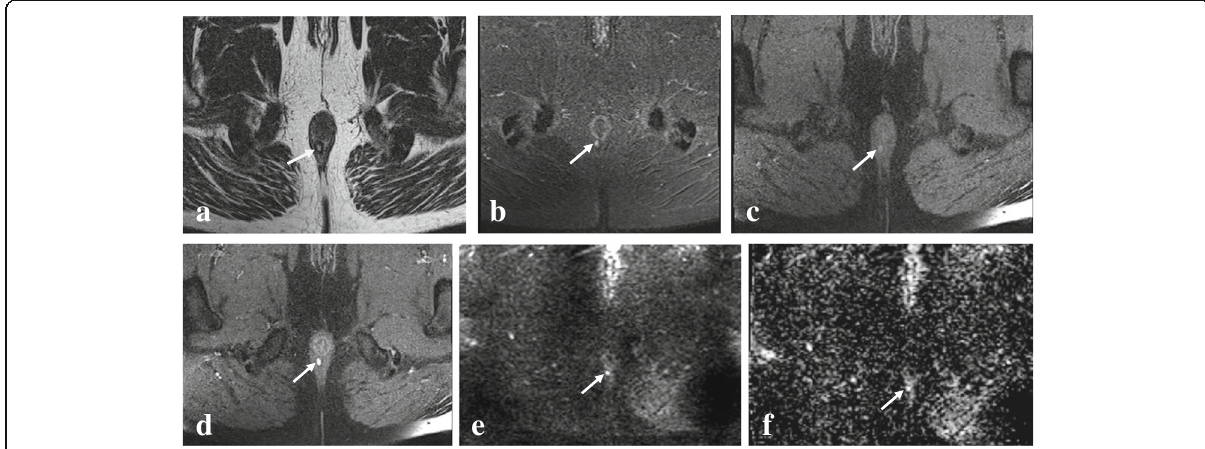
Fig. 6 A 51-year-old man with inter-sphincteric fistula without abscess. a Axial T2-weighted image shows a perianal fistula (arrow) that exhibits high signal intensity. b Axial STIR-weighted image reveals high signal intensity of the fistula (arrow). c Axial T1 fat-saturated weighted image reveals intermediate signal intensity of the fistula (arrow). d Axial T1 fat-saturated post-contrast injection weighted image reveals intense contrast enhancement of the fistula (arrow). e Axial diffusion-weighted image reveals high signal intensity of the fistula (arrow). f Axial ADC mapping reveals high signal intensity of the fistula